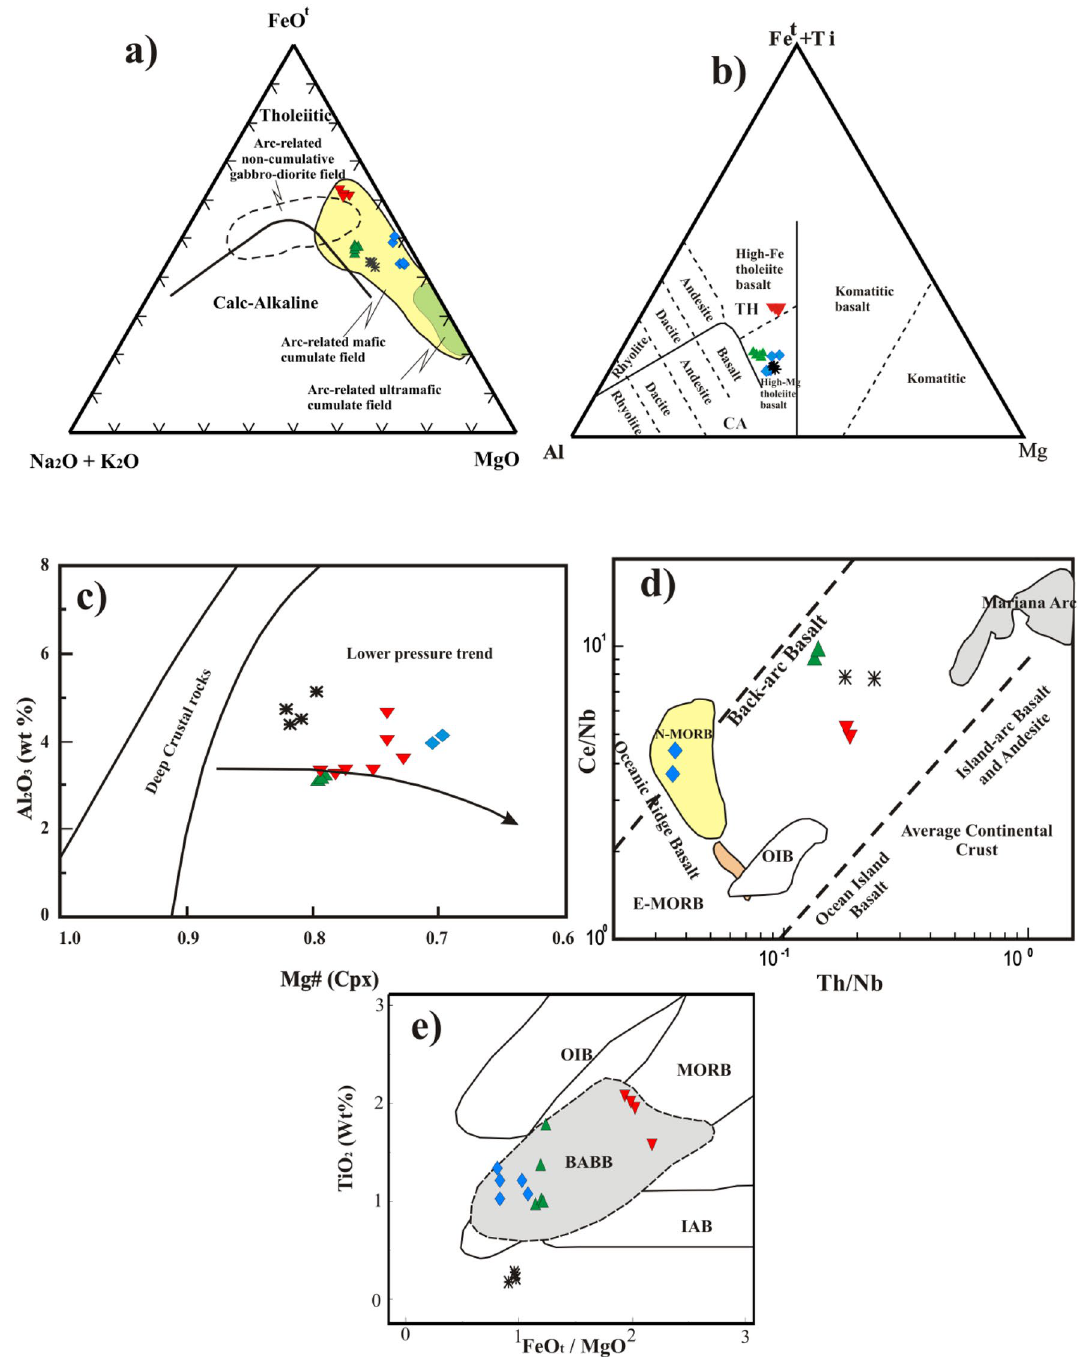
Figure 12. ( a ) AFM ternary diagram 47 for the studied mafic- rocks. Fields of cumulate and non-cumulate arc- related ultramafic–mafic rocks are from 46 , ( b ) Fe t + Ti–Al–Mg diagram 48 , ( c ) Variation diagram of Al 2 O 3 (wt %) vs. 100*Mg# of clinopyroxene 21 , ( d ) Th/Nb versus Ce/Nb diagram 52 , fields are from 53 . The samples plot in the back arc field, and ( e ) FeOt/MgO-TiO2 diagram 54